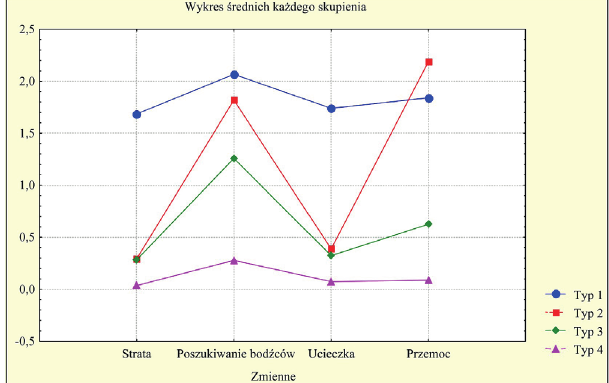
(tabela 1) oraz testu post hoc Tukeya (tabela